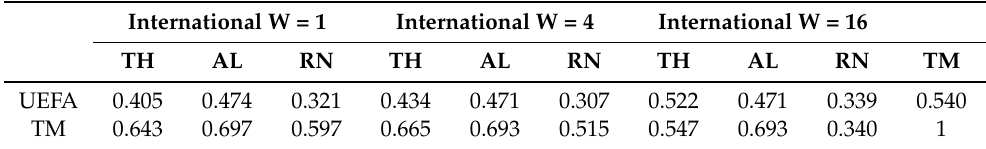
Table 8. Kendall’s tau rank correlations between the different